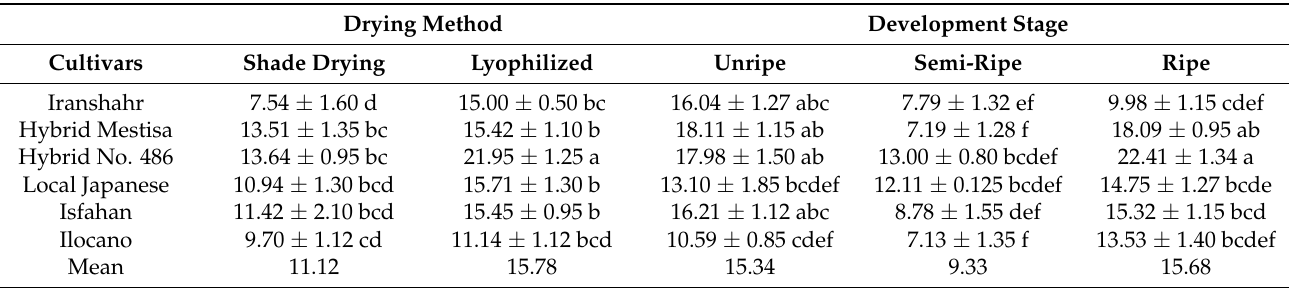
Table 6. Cultivar × drying method and cultivar × development stage interaction effects on fruit total phenolic content (mg